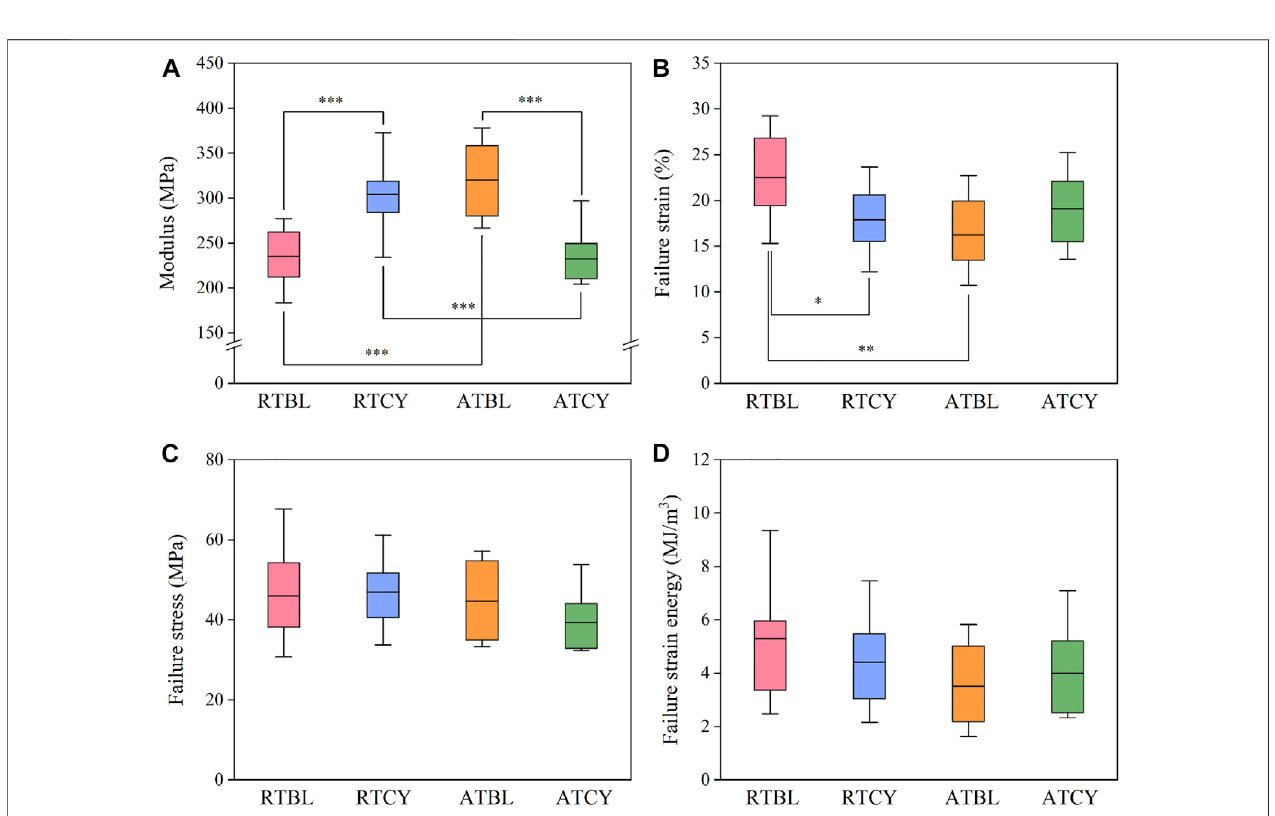
FIGURE 6 | Material properties of each group: (A) Modulus; (B) Failure strain; (C) Failure stress; (D) Failure strain energy. The box shows the mean ± interquartile range, and the whiskers show the minimum/maximum values. Signi fi cant differences are indicated as: * p < 0.05, ** p < 0.01, *** p <